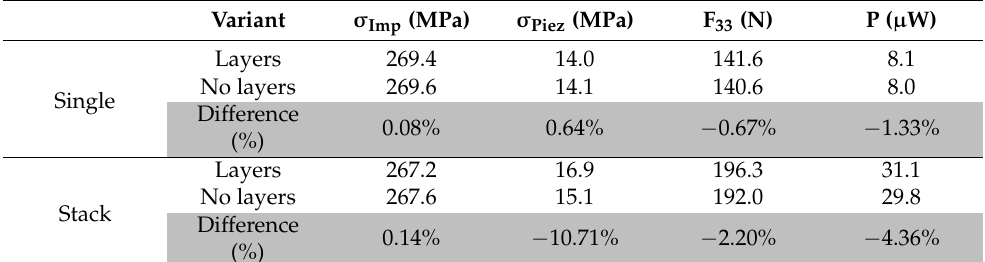
Table 4. Comparison of output data when considering or neglecting the individual layers of the piezoelectric element during